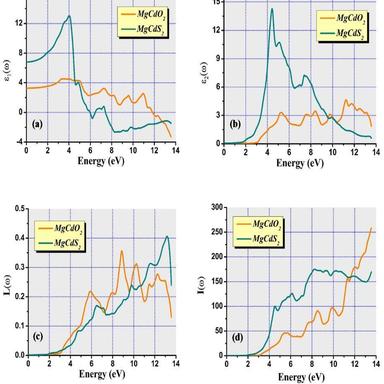
Calculated (a) real component, (b) imaginary components of dielectric function (c) Energy loss function L(ω) (d) Absorption coefficient I(ω) for MgCdX2 (X ¼ O, S) materials respectively.